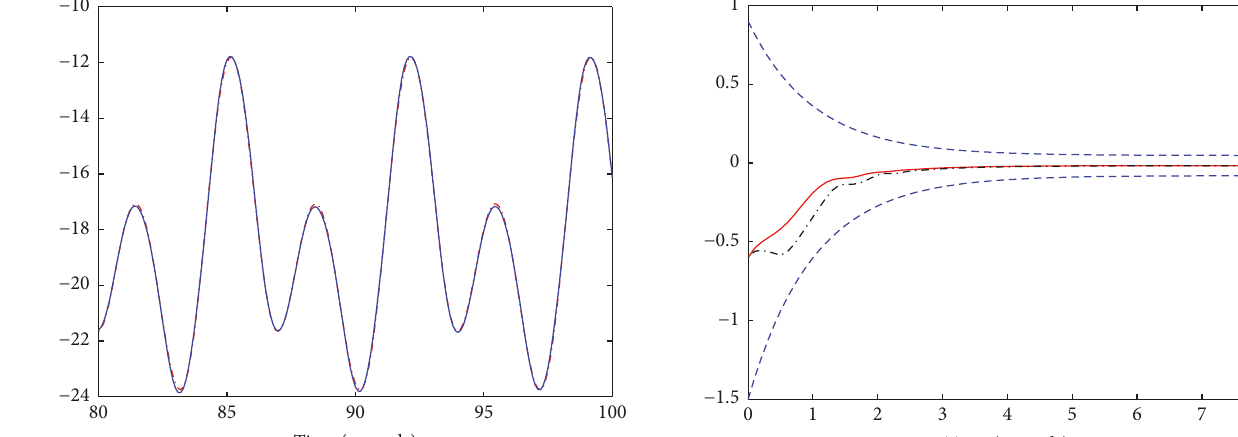
required to have the similar amplitude, which is shown in Figure 6. The simulation results for comparison are given